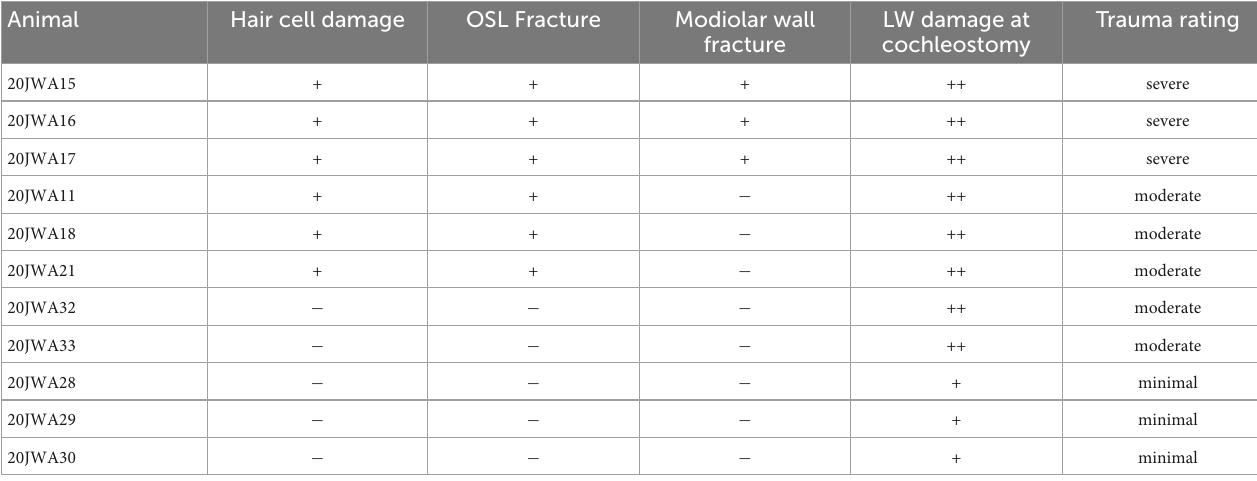
TABLE 1 Trauma severity assessment based on histology. Animal Hair cell damage OSL Fracture Modiolar wall